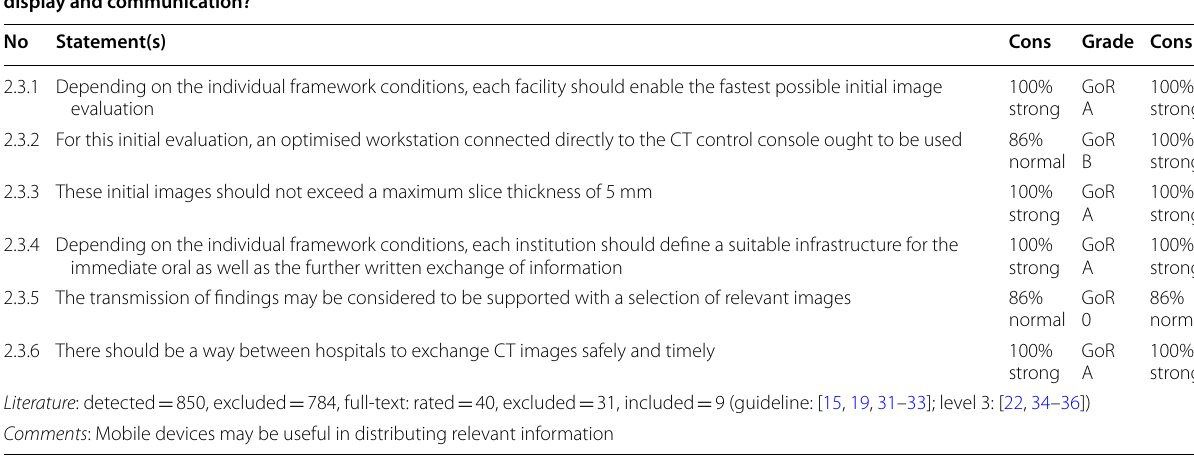
Table 4 Section 2: Structural points, key issue 3: Diagnostic Environment and